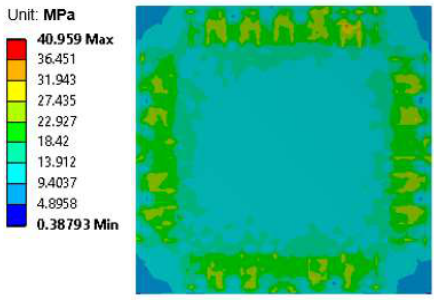
Figure 14. Stress distribution map of the silicon chip after the bonding process.